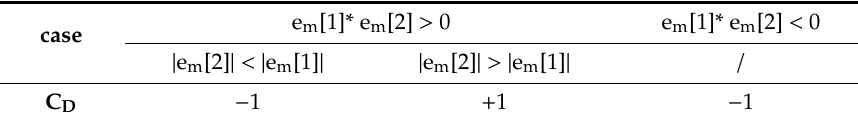
Table 1. Value of C D in di ff erent conditions of e m [1] and e m [2].